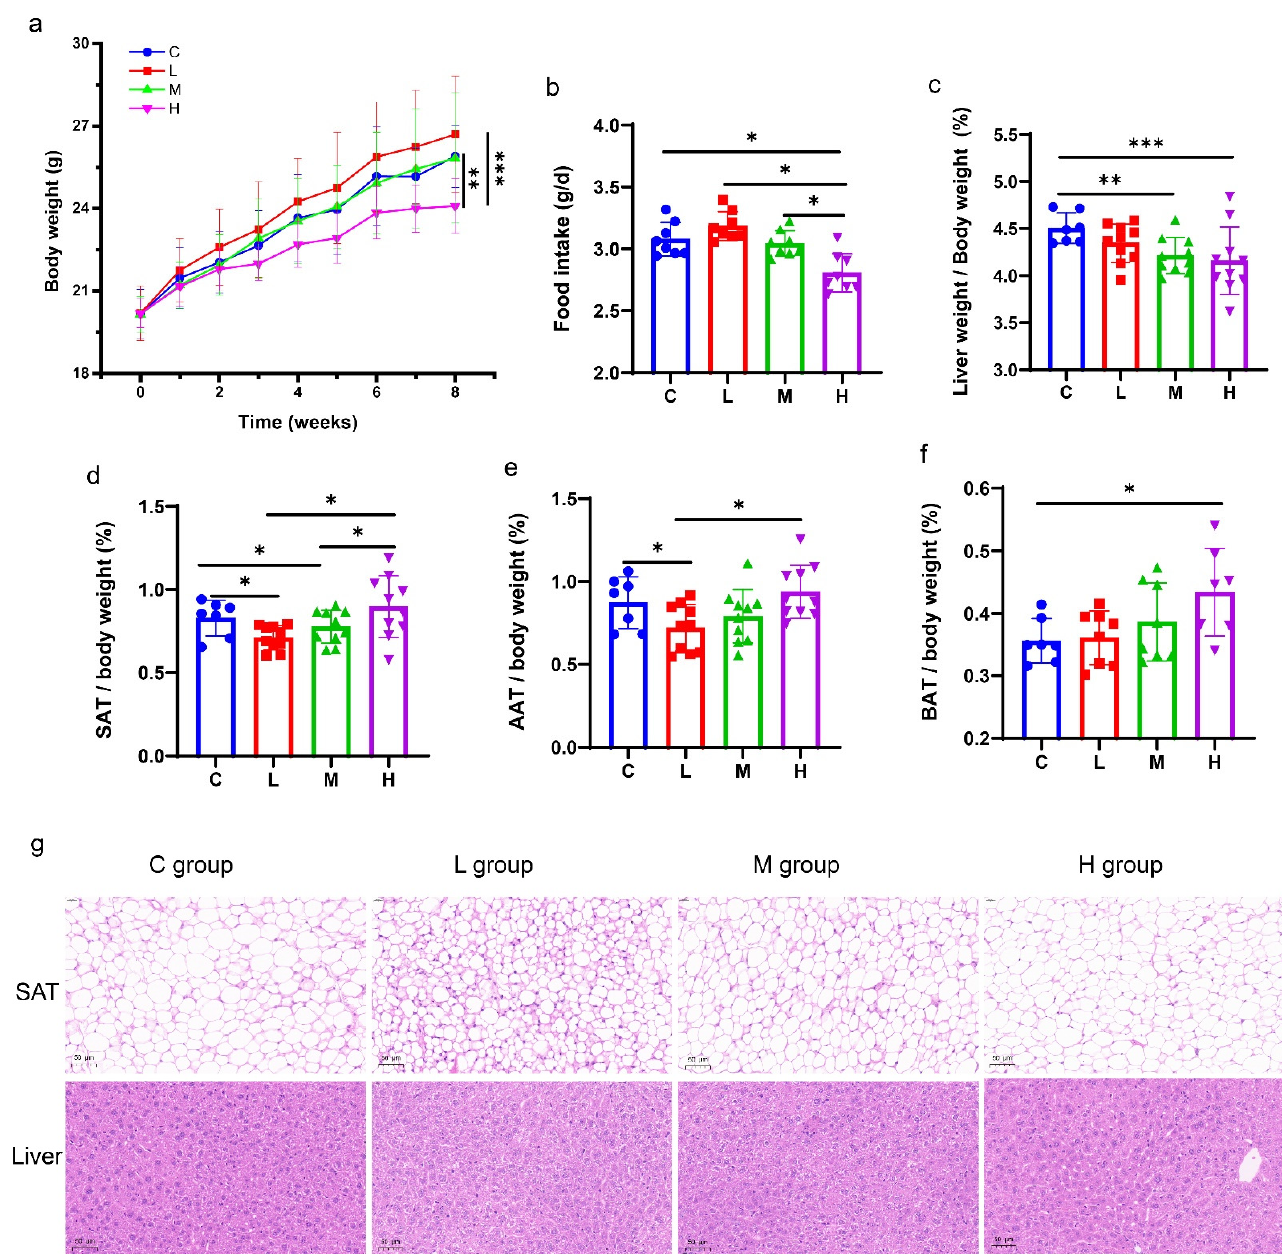
Figure 5. CFJ preventing the development of obesity. ( a ) Body weight changes in mice ( n = 7–10, the control group was expressed as C, and the groups supplemented with low concentration, medium concentration, and high concentration FCJ were expressed as L, M, and H, respectively), ( b ) the average daily food intake of the mice, the ratio of the liver ( c ), subcutaneous adipose tissues ( d ), abdominal adipose tissues ( e ), and brown adipose tissues to the body weight ( f ), ( g ) The observation of the SATs and liver by H&E staining (40×). * p < 0.05, ** p < 0.01, and *** p < 0.001.